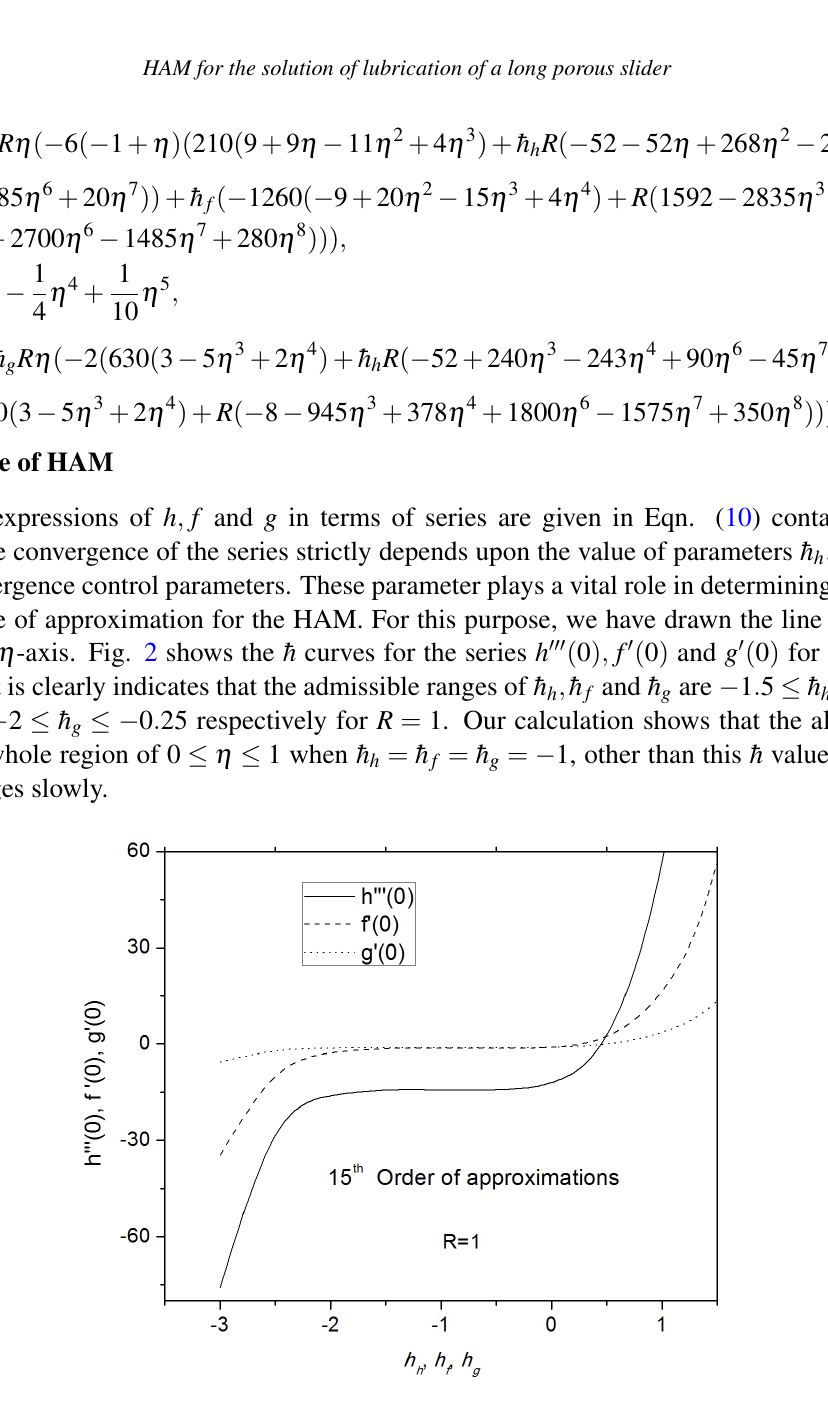
Fig. 2 ¯ h curves for the series h (cid:48)(cid:48)(cid:48) ( 0 ) , f (cid:48) ( 0 ) and g (cid:48) ( 0 ) for R =